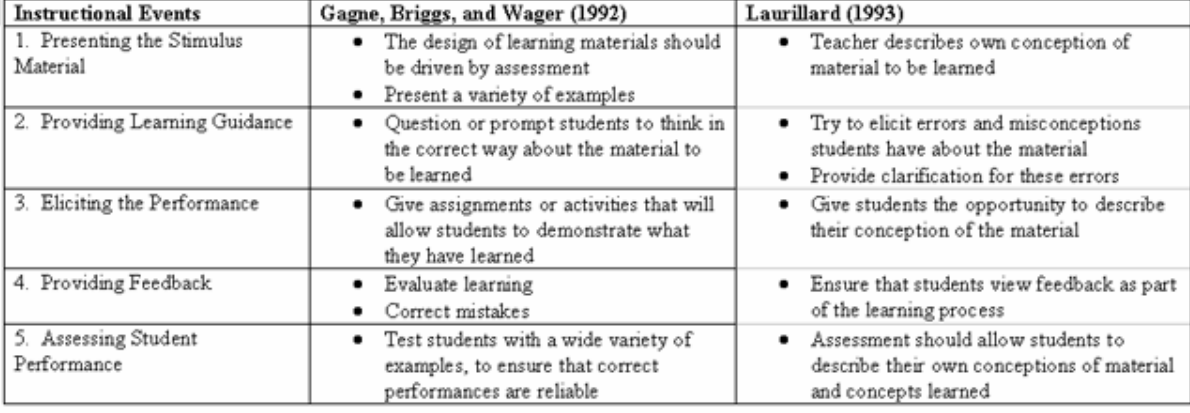
Figure 1. Five events of Instruction Defined by Gagne, Briggs, and Wager (1992) Compared with Laurillard's (1993) Steps in the Learning